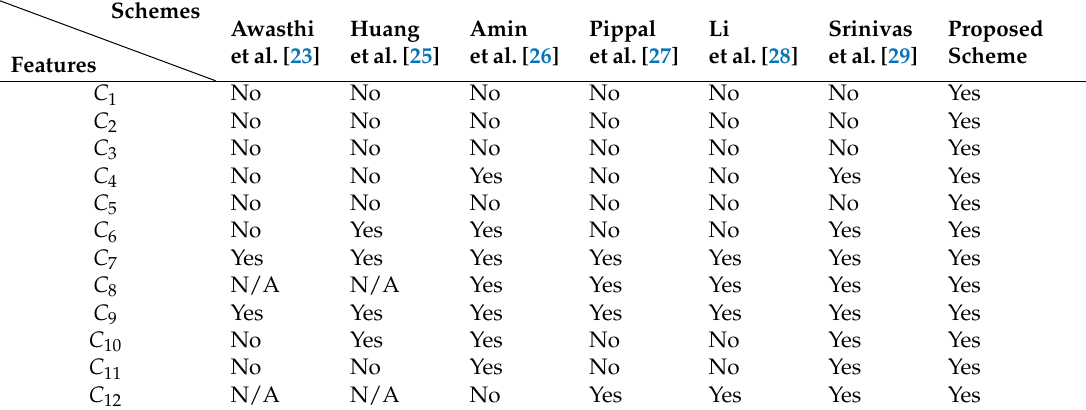
Table 5. Comparison of security features.